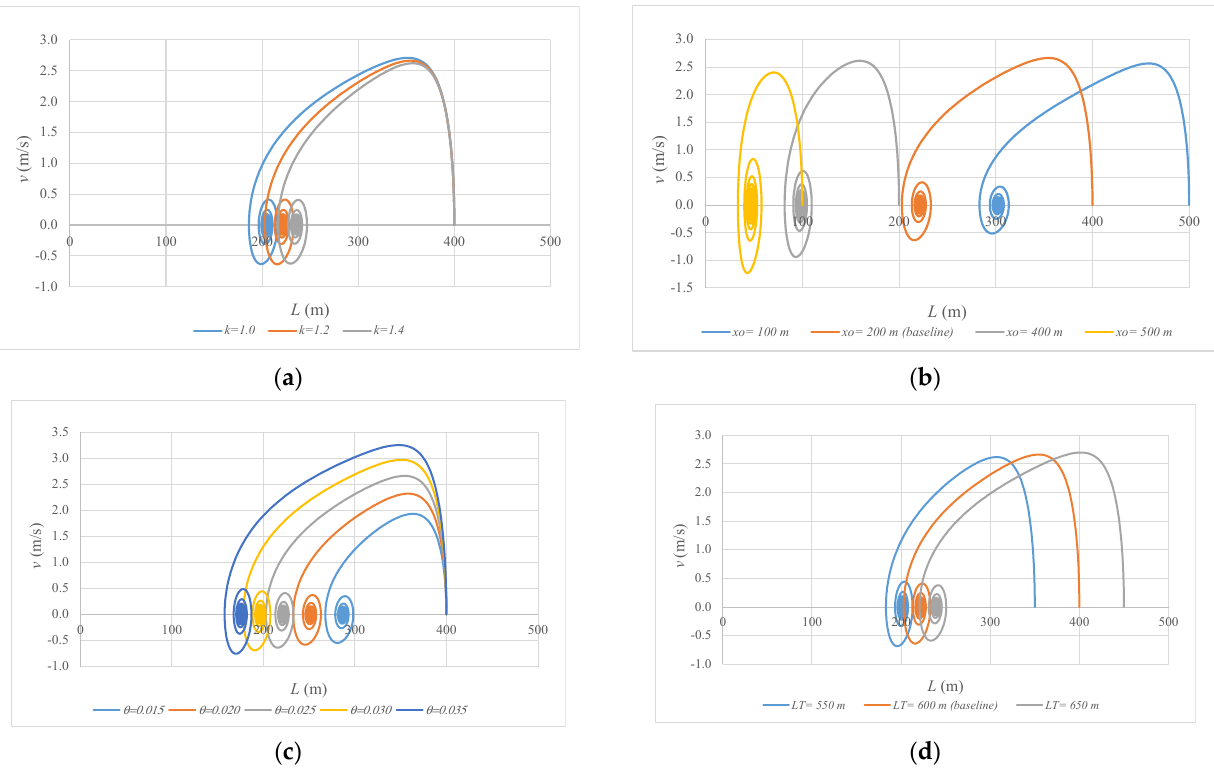
Figure 9. Sensitivity analysis for dependent parameters: ( a ) polytropic coefficient ( k ); ( b ) initial air pocket size ( x 0 ); ( c ) slope pipe ( θ ); and ( d ) total pipe length ( L T ). The Newton–Raphson method should be applied when considering seed values (SVs) varying from 0 to L T - x 0 (0 to 400 m). If an isothermal evolution ( k = 1.0) is presented, then the final position of the water column length can be computed using Equation (14). For other polytropic coefficients ( 1.0 < 𝑘 ≤ 1.4) , Equation (14) can be used for a seed value. A sensitivity analysis was performed using seed values from 0 to 400 m (see Figure 10). For all seed values, the Newton–Raphson method is suitable to compute the final po- sition of the water column length (221.20 m). The seed value computed with Equation (14) ( SV = 204.33 m) was the best starting point to calculate the final position of the water col- umn length.